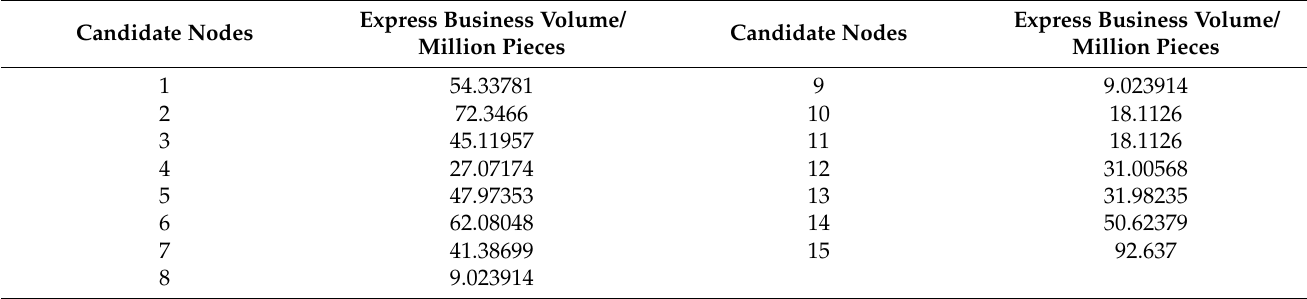
Table 8. Express the business volume of each candidate node.